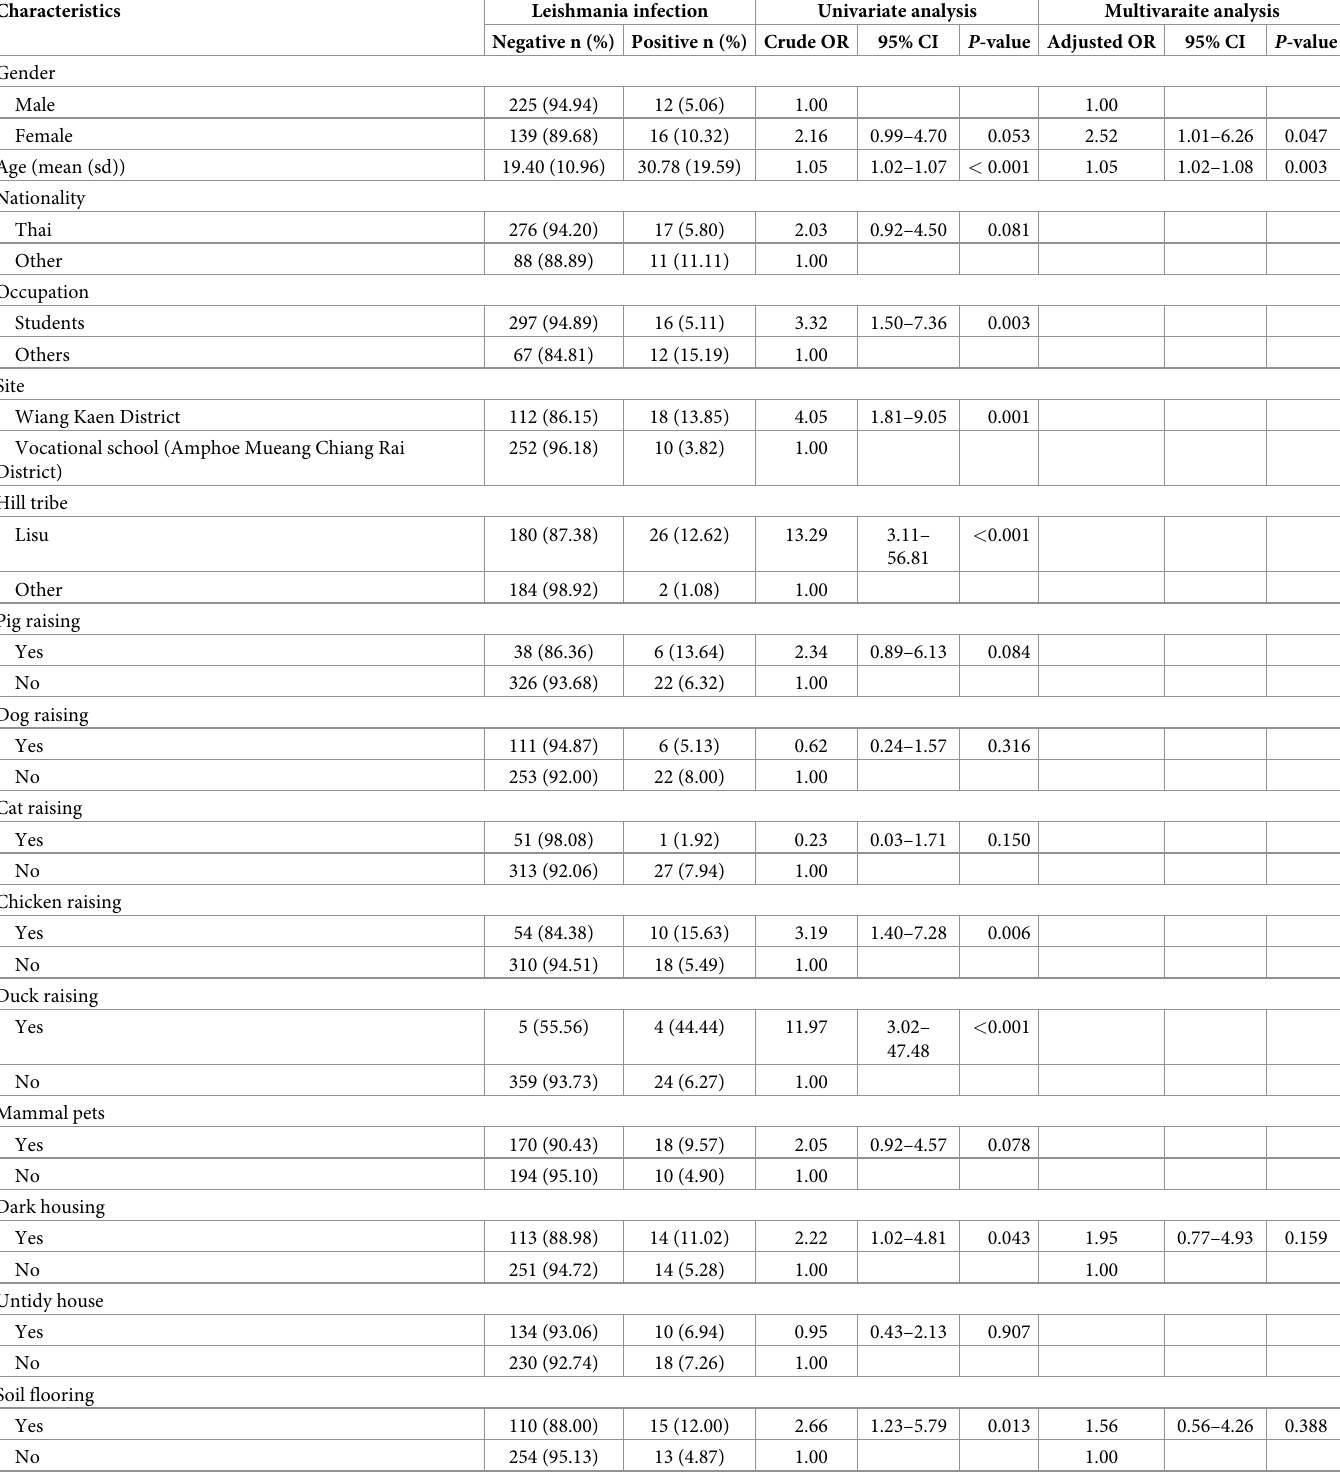
Table 3. Univariate and multivariate analysis of risk factors of Leishmania infection among patients in Chiang Rai Province, Thailand (n = 392).